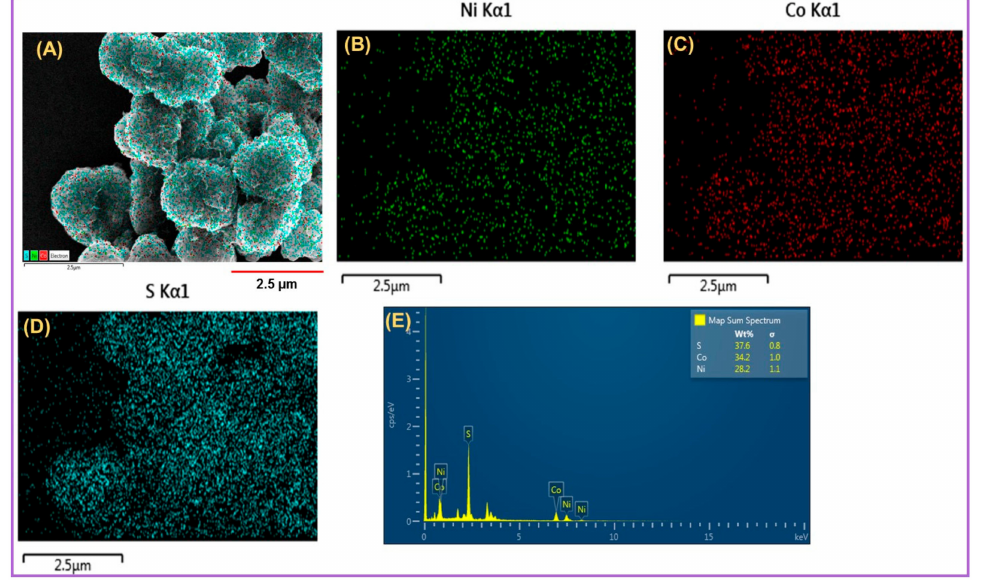
Figure 2. ( A ) Mapping image NiCo 2 S 4 -Ms mix, ( B ) Ni, ( C ) Co and ( D ) S. ( E ) EDX profile of NiCo 2 S 4 -Ms. Inset weight percentage of NiCo 2 S 4 -Ms. Scale bar 2.5 µ